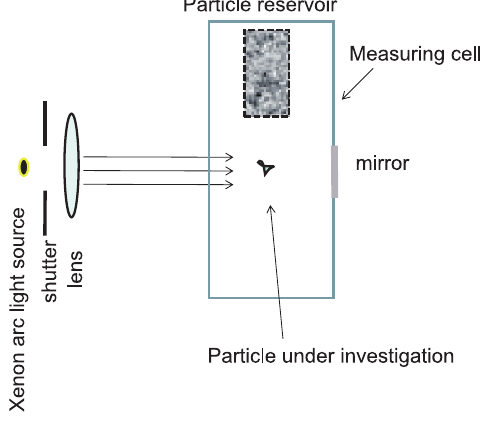
Fig. 17 Measurement of gravito-photophoresis. The cell is illu- minated by light through one of the windows, and obser- vation is perpendicular to this direction. Particles in the reservoir are released by knocking the cell slightly. Parti- cles which show photophoresis are trapped at the top of the beam. Closing the shutter causes the particles to sed- iment, with open shutter the gravito-photophoretic velocity can be measured (Jovanović,